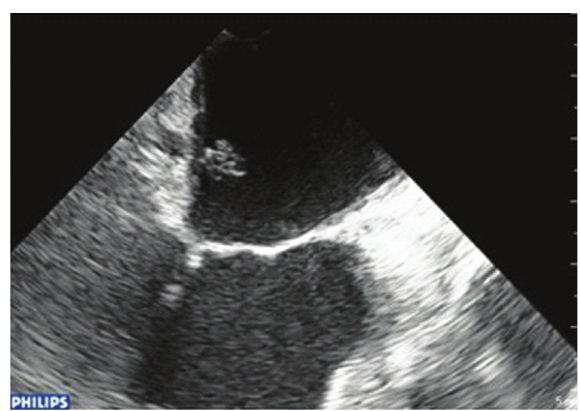
Figure 1: Transesophageal image of the left atrial mass.